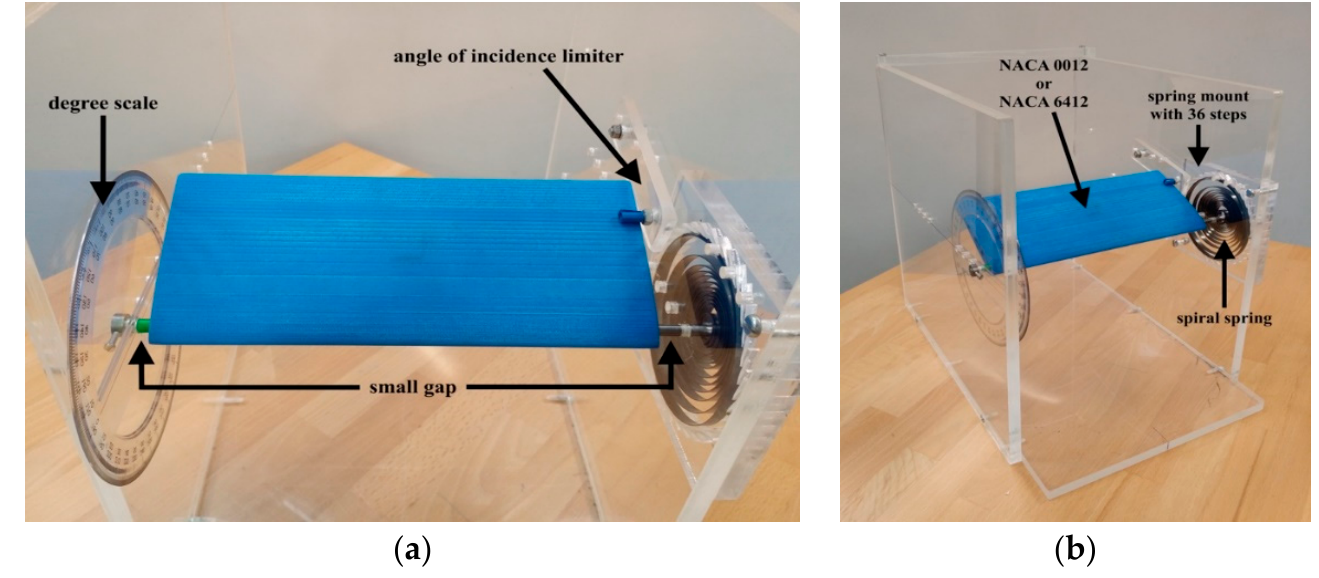
Figure 2 . Experimental setup ( a ) zoomed in ( b ) complete rig . Figure 2. Experimental setup ( a ) zoomed in ( b ) complete